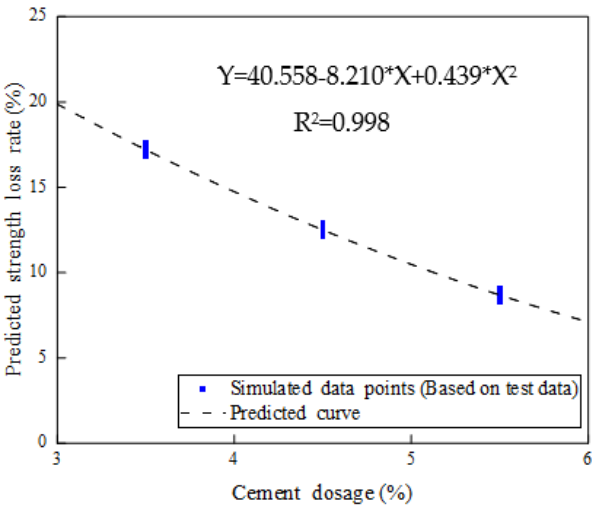
Figure 25. Nonlinear strength-loss-rate fitting equation with respect to freezing-damage effects.